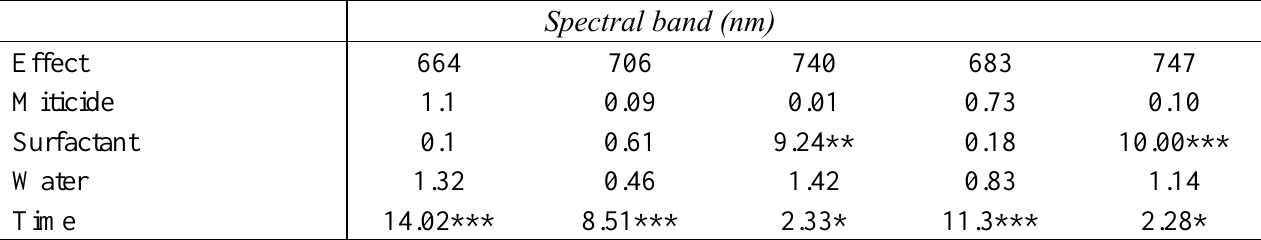
Table 2. F-values from analysis of variance of average reflectance data in five spectral bands.